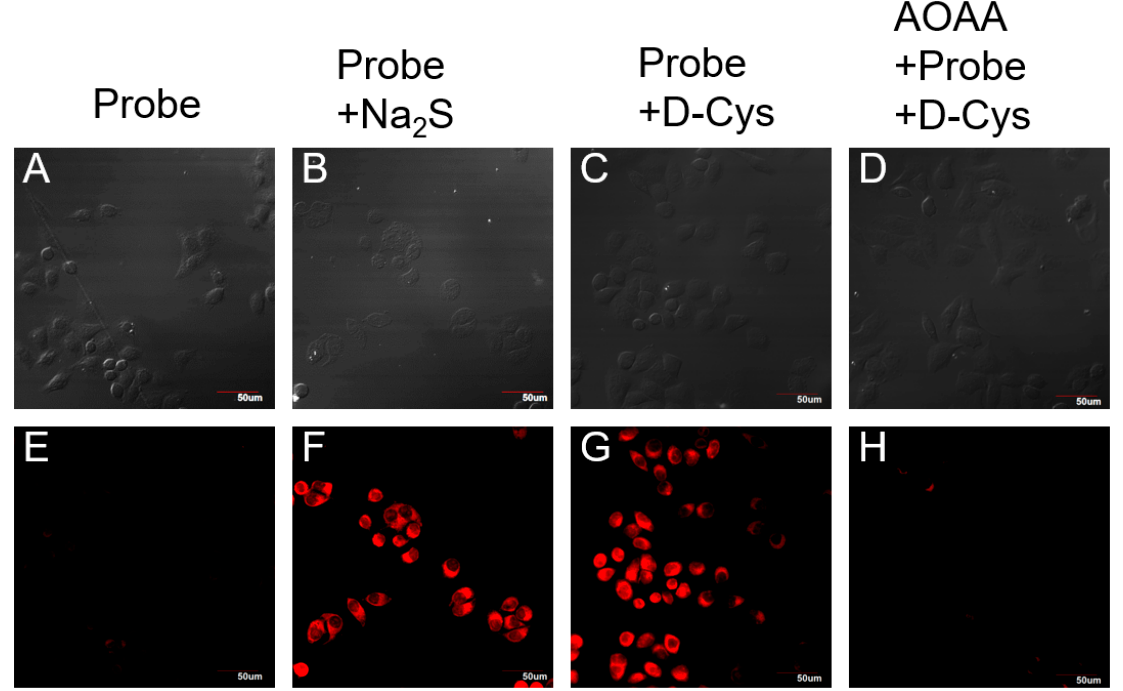
Figure 5. Fluorescence images of probe 1 for H 2 S detection in living cells. Bright-field and fluorescence images of cells upon incubation with 1 (5 µM) for 30 min ( A, E ); with 1 and Na 2 S (100 µM) ( B , F ); with 1 and D-Cys (100 µM) ( C, G ); with inhibitor (AOAA), 1 and D-Cys (100 µM) ( D, H ). Scale bars: 50 µm.